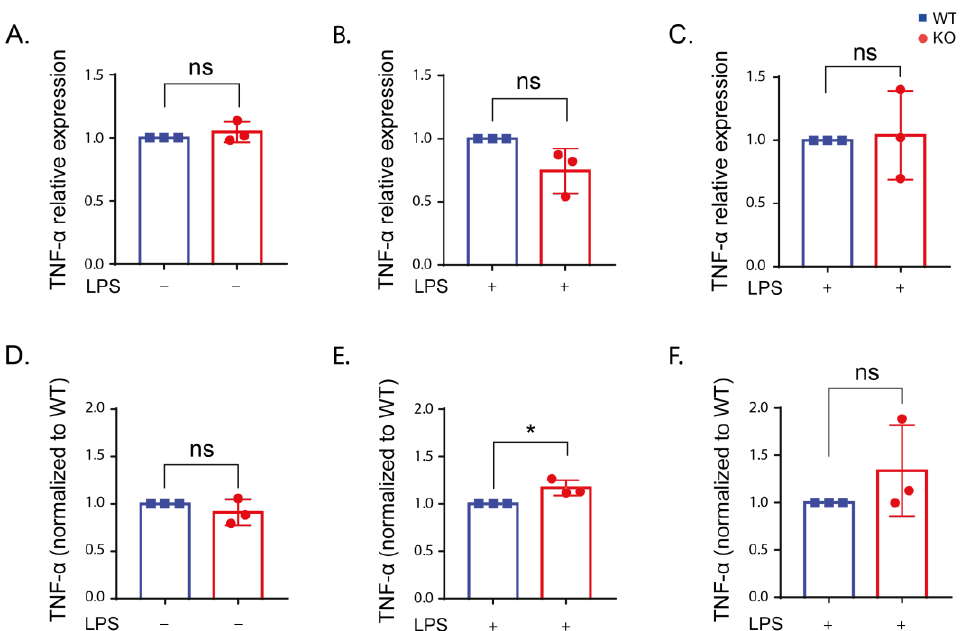
Figure 5. TNF- α expression is not altered in the presence or absence of LRRK2 after LPS stimulation. ( A – C ) TNF- α expression in the WT and KO cells under control conditions ( A ) and after LPS stimulation for 6 ( B ) and 24 h ( C ) using reverse transcription quantitative real-time PCR using β -actin and RPL13A as housekeeping genes. ( D – F ) The amount of TNF- α in the supernatant of the WT and KO cells under control conditions ( D ) and after LPS stimulation for 6 ( E ) and 24 h ( F ) using ELISA assay. The experiment was performed 3 times and t-test was used to compare the average TNF- α expression or level normalized to the corresponding WT. Error bar represents mean ± SD. p -values indicating statistically significant differences between the mean values are defined as follows: ns — not significant, * p < 0.05.